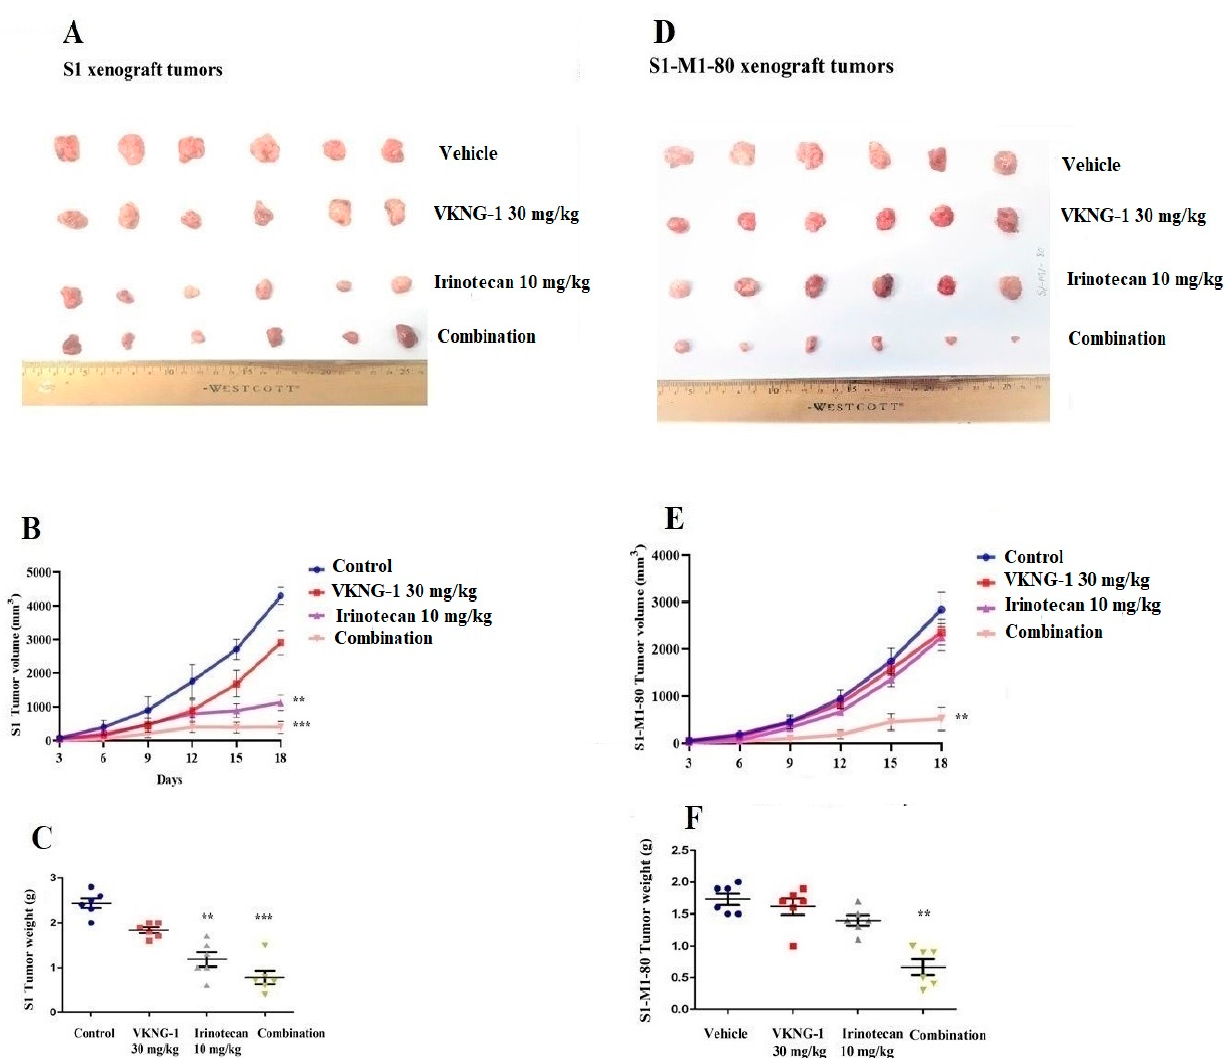
Figure 8. VKNG-1 inhibits ABCG2 activity in vivo. Effect of VKNG-1 on parental S1 and drug resistant S1-M1-80 cells.